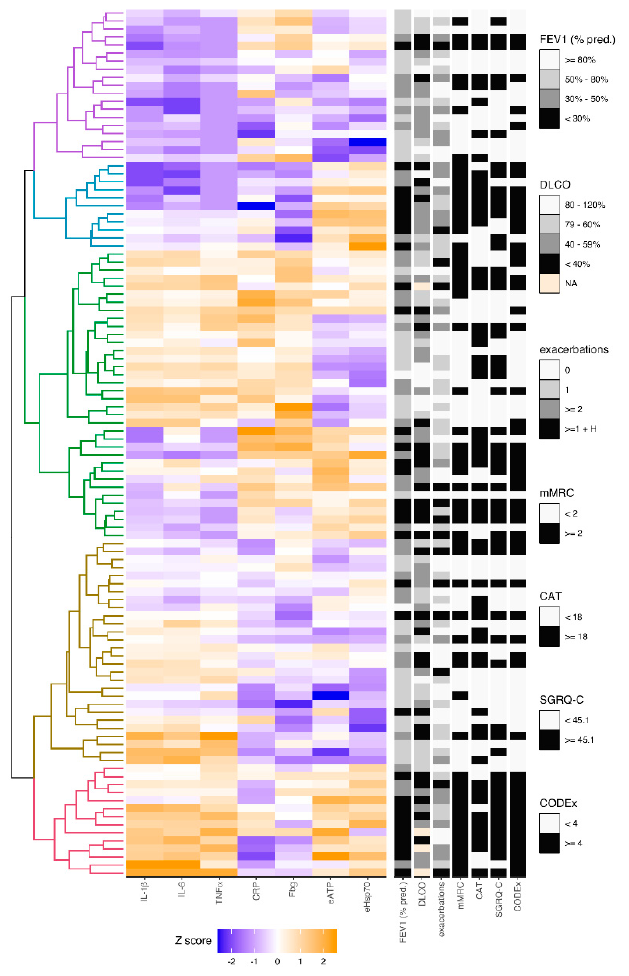
Figure 3. The heatmap of clusters of COPD patients regarding concentrations of cytokines (IL-1 β , IL-6, TNF α ), common inflammatory parameters (CRP, Fbg) and DAMPs (eATP, eHsp70). Hierarchical clustering analysis was used to characterize different phenotypes in COPD patients based on concentrations of cytokines (IL-1 β , IL-6, TNF α ), common inflammatory parameters (CRP, Fbg) and DAMPs (eATP, eHsp70). All concentrations were rank-based inverse normal transformed, and Euclidian correlation test with complete linkage was used for the clustering analysis. The heatmap shows colored squares, which present values of each parameter in each COPD patient. Five clusters of COPD patients were identified (left), and their clinical data (right) was included in the analysis, too. DAMP–damage-associated molecular pattern; IL-1 β —interleukin-1beta; IL-6—interleukin-6;